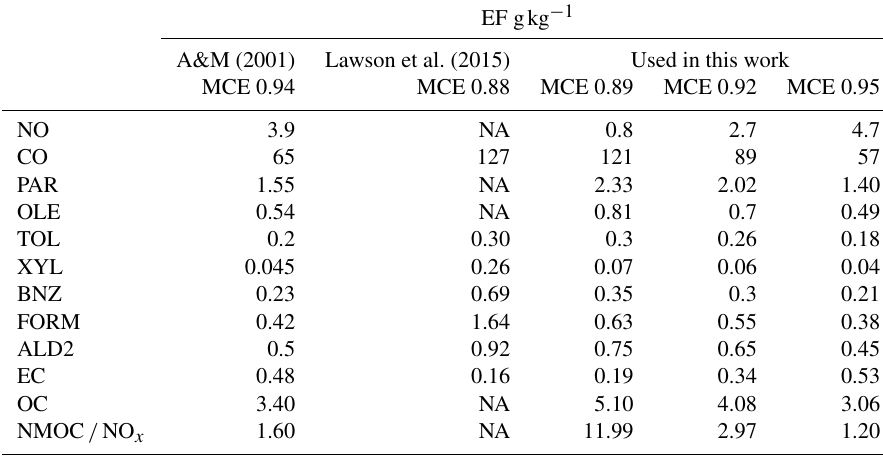
Table 1. EF used in model sensitivity studies, corresponding to low (MCE = 0 . 89), medium (MCE = 0 . 92) and high (MCE = 0 . 95) MCEs. A subset of the total species included in the CB05 lumped chemical mechanism are shown. Also shown are savannah EFs from Andreae and Merlet (2001) (A&M) and EFs calculated from BB2 in previous work (Lawson et al., 2015). NO: nitric oxide, CO: carbon monoxide, PAR: paraffin carbon bond, OLE: terminal olefin carbon bond, TOL: toluene and other monoalkyl aromatics, XYL: xylene and other polyalkyl aromatics, BNZ: benzene, FORM: formaldehyde, ALD2: acetaldehyde, EC: elemental carbon < 10µm and OC: primary organic carbon < 10µm.